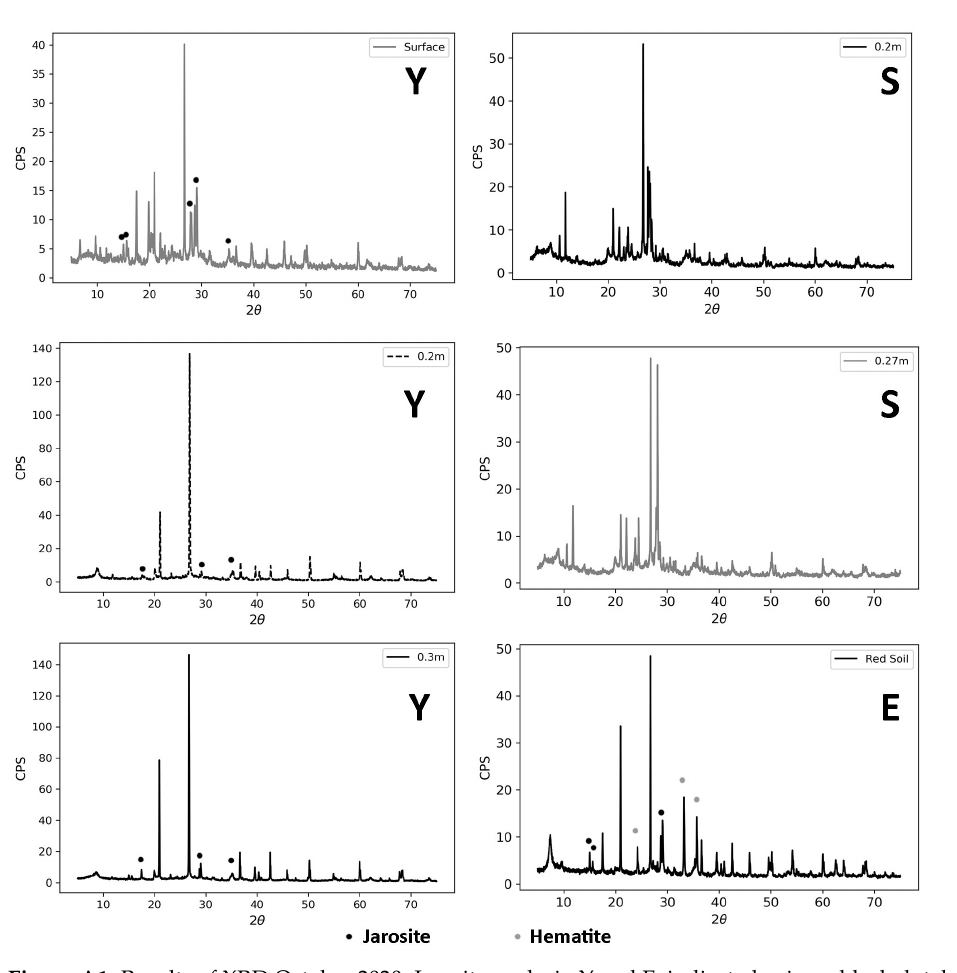
Figure A1. Results of XRD October 2020. Jarosite peaks in Y and E, indicated using a black dot, have weak peaks in the 2 θ values of 14.9, 15.5, 28.6, 29, and 35.3 ◦ . Hematite peaks in E, indicated using a gray dot, have weak peaks in the 2 θ values of 24.2, 33.2, and 35.7 ◦ , and quartz has strong peaks in the 2 θ values of 2.8, 26.6, and 36.5 ◦ in all